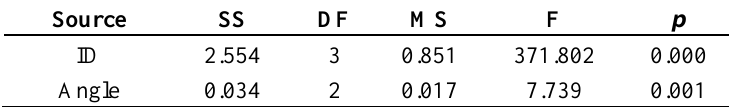
Table 5. ANOVA for the mean time of the teach pen operation.